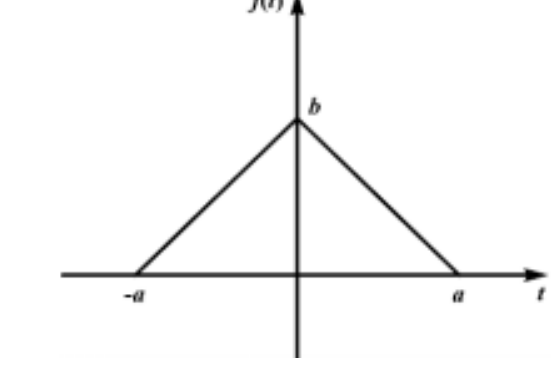
Fig. 6. Triangular pulse.